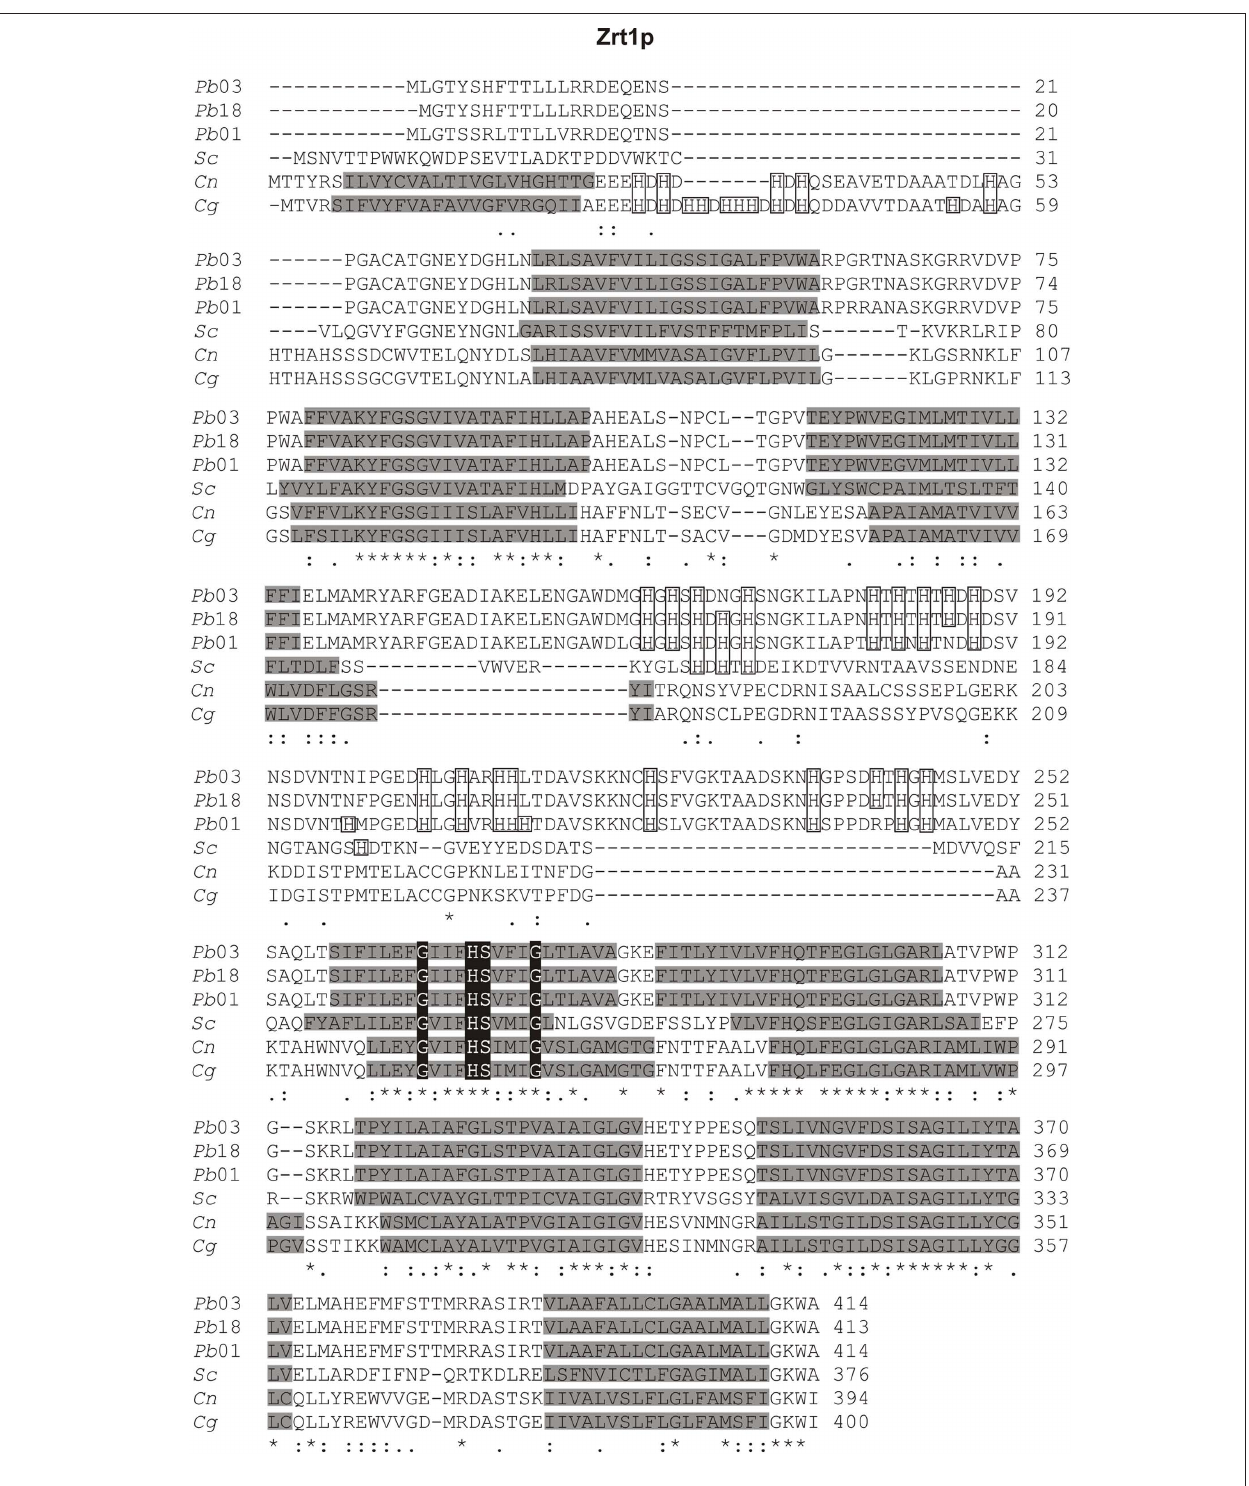
FiGure 5 | Alignment of amino acid sequences of Zrt1p from S. cerevisiae , P. brasiliensis isolates and Cryptococcus species. The predicted transmembrane domains are shown in gray boxes. The black boxes inside the transmembrane segment contain conserved histidine-serine and glycine residues. The histidines found in the amino-terminal region of Zrt1p from